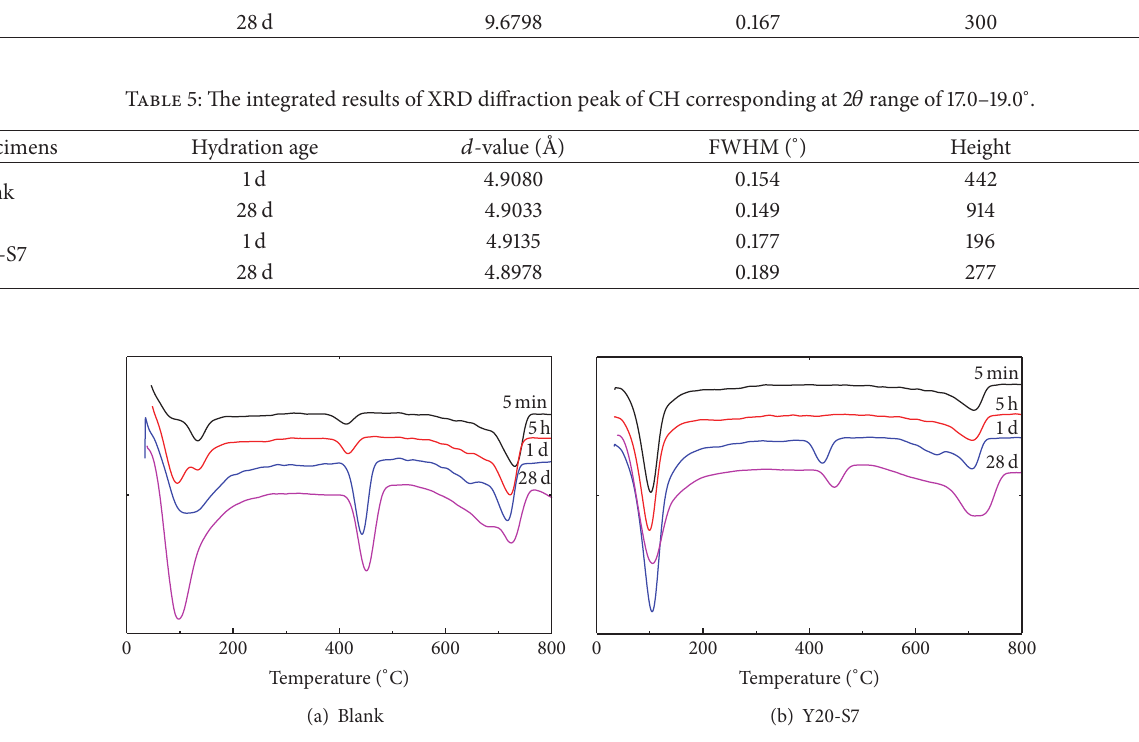
Figure 4: DTG curves of hydrated